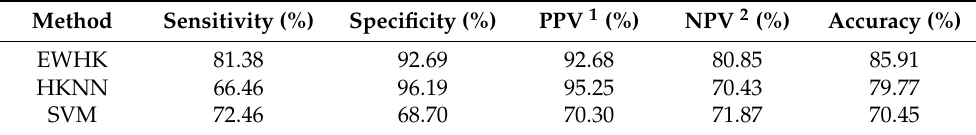
Table 3. Comparison of the average of statistical analysis results with several classification